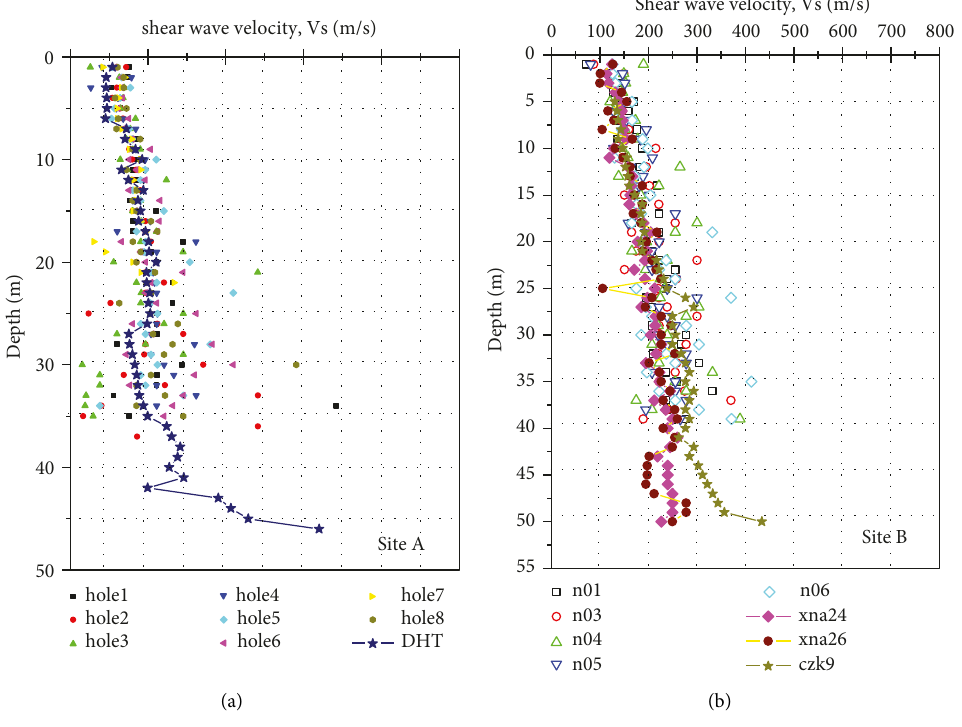
Figure 9: Comparison of SCPTU and DHT data from Site A (a) and Site B